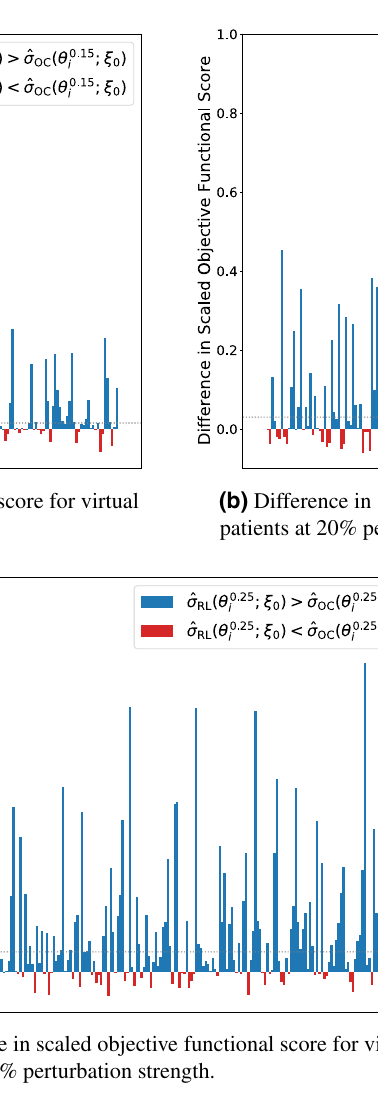
Figure 7. Bar plots of the difference between the scores obtained by the reinforcement learner derived policy and the scores obtained by the optimal control derived policy on all test virtual patients (i.e. bar plots of ˆ σ RL (θ k i ; ξ 0 ) − ˆ σ OC (θ k i ; ξ 0 ) ). Testing patients where the reinforcement learner outperformed the optimal controller are marked in blue and patients where the optimal controller outperformed the reinforcement learner are marked in red. The dotted grey lines in each plot indicate the difference of the median scaled scores of the reinforcement learner and the optimal